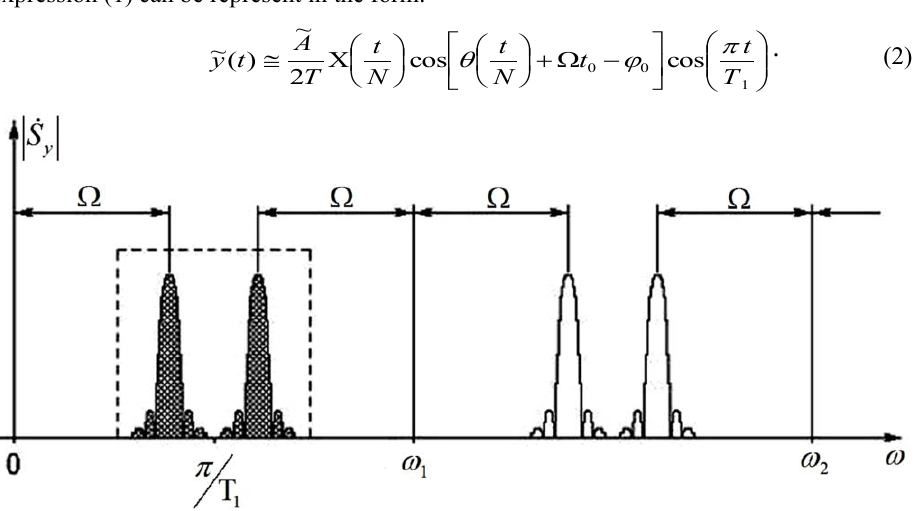
Fig. 2. It’s shown a synchronization of spectral components with  and 